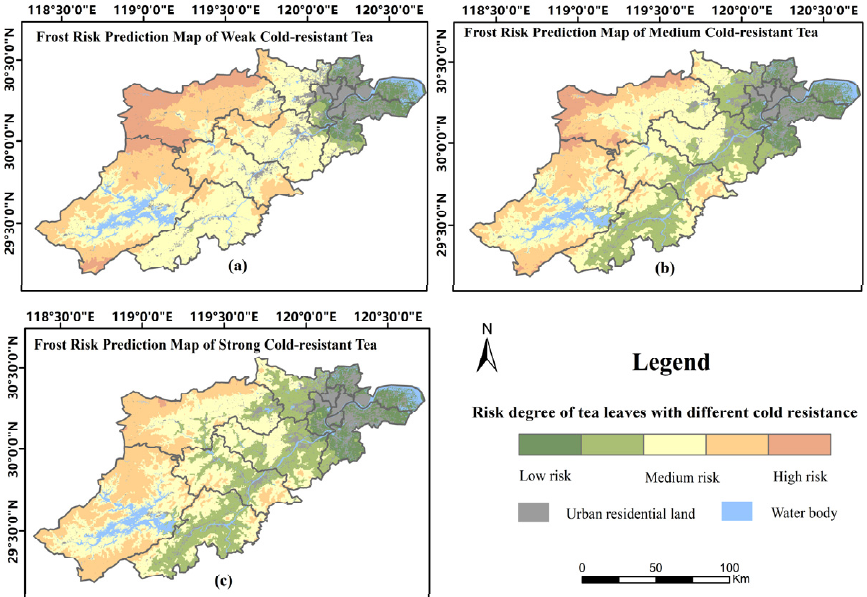
Figure 7. Frost disaster risk map of tea with different cold resistance: ( a ) Prediction of freezing injury risk of tea with weak cold resistance; ( b ) Prediction of risk of freezing injury of tea with moderate cold resistance; ( c ) Prediction of risk of freezing injury of tea with strong cold resistance. Table 5. The proportion of frost disaster results in teas with different cold resistance.